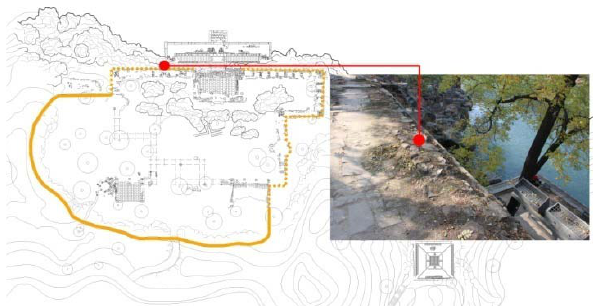
Figure 4. Traces of the wall of the Qiwang Hall